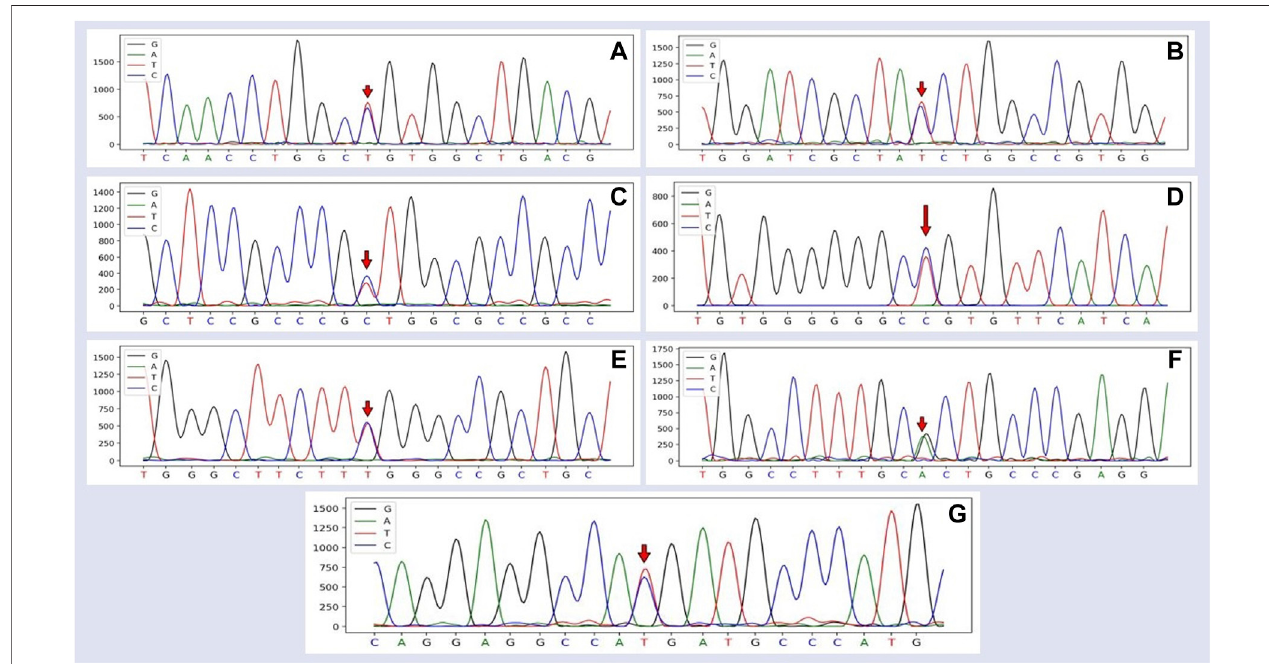
FIGURE 1 | Sequencing peak map of the SSTR5 and the mutated SNP1 – 7 site of Hulun Buir sheep. The sequences were analyzed using DNAMAN software. (A) The site marked by the red arrow was the SNP1 mutation, which was found and identi fi ed in exon 2 of SSTR5 , C186T (rs400944340). (B) The site marked by the red arrow wastheSNP2mutation,whichwasfoundandidenti fi edinexon2of SSTR5 ,C351T (rs404123088). (C) ThesitemarkedbytheredarrowwastheSNP3mutation, which was found and identi fi ed in exon 2 of SSTR5 , T384C (rs413380618). (D) The site marked by the red arrow was the SNP4 mutation, which was found and